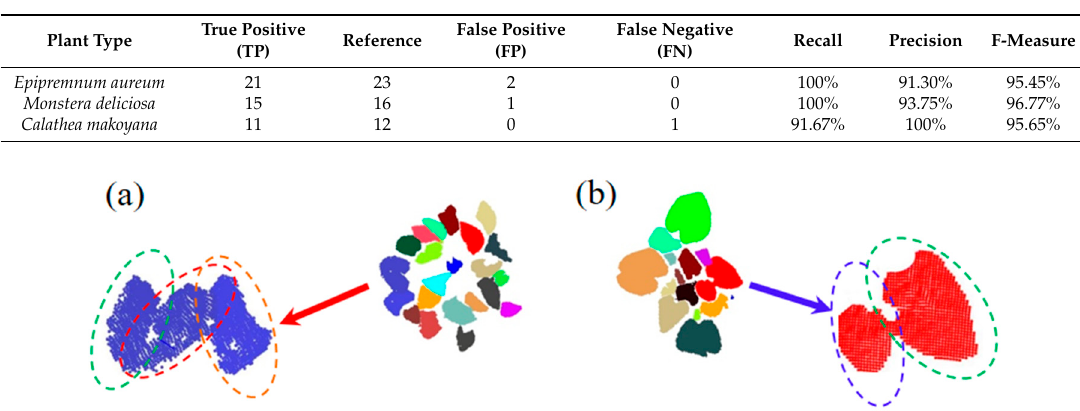
Figure 8. False Positives (FP) in two sample point clouds: ( a ) the two FPs for the point cloud of